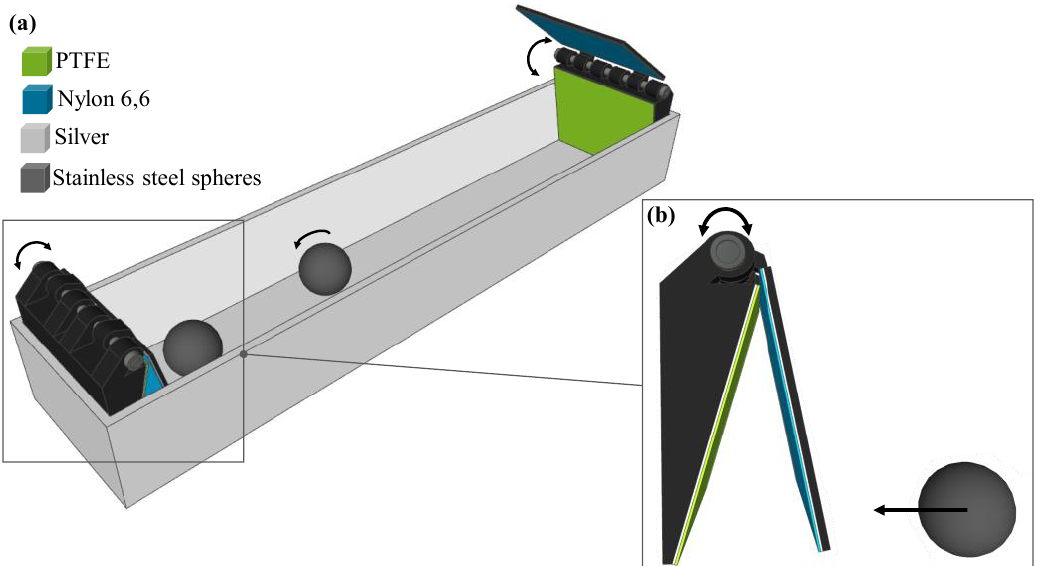
Figure 4. ( a ) Structural design of the fabricated unidirectional lateral TENG and ( b ) the schematic illustration of the closing of the triboelectric nanogenerator placed at each side of the linear trough.